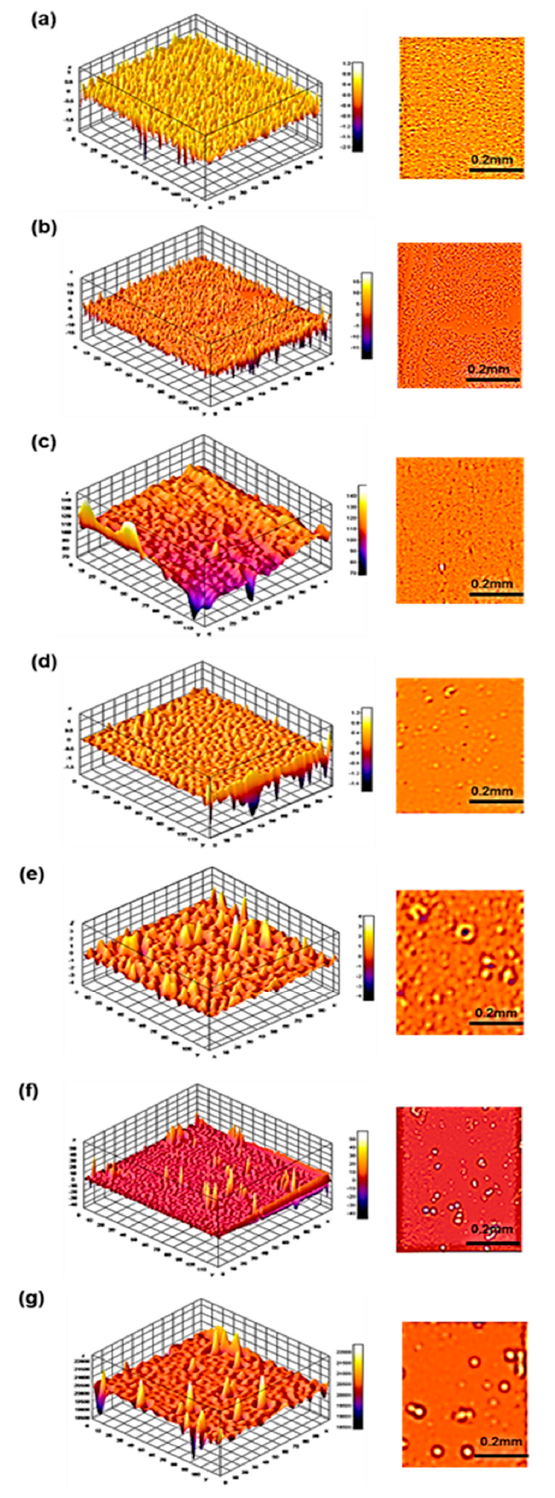
Figure 5. Three- and two-dimensional images of all coating studied: ( a ) original substrate; ( b ) PVA/GA coating; ( c ) PVA/GA/AgNPs; ( d ) PVA/GA/TiO 2 -NPs; ( e ) PVA/GA/ZnONPs; ( f ) PVA/AG/Ag-TiO 2 NPs and ( g ) PVA/AG/CuONPs.